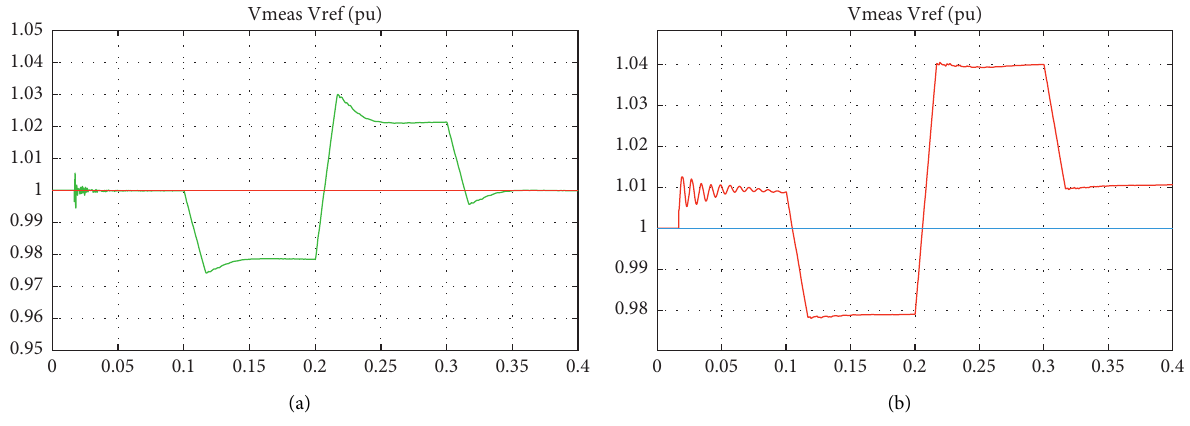
Figure 13: Voltage measurement: (a) with PI and (b) with fuzzy and PI